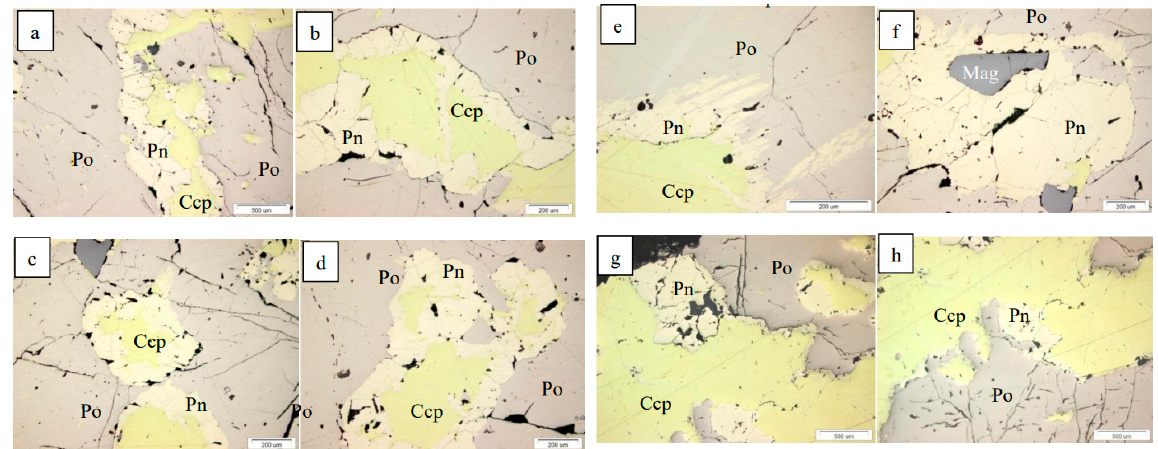
Figure 8. Photomicrographs (reflected light) of the massive ore from the orebody C-5. ( a ) fragment of looped texture of chalcopyrite-pyrrhotite aggregate, ( b ) looped texture of pentlandite-chalcopyrite association, ( c , d ) fire-like grains on the chalcopyrite-pyrrhotite boundary, (e) flame-like segregations towards the surrounding pyrrhotite aggregate; ( f ) porhyric pentladite crystal in pyrrhotite, ( g ) ideomorphic pentlandite crystal in chalcopyrite, ( h ) pentlandite grains around pyrrhotite. Here and in Figure: Ccp: chalcopyrite, Po: pyrrhotite, Pn: pentlandite, Mag: magnetite.